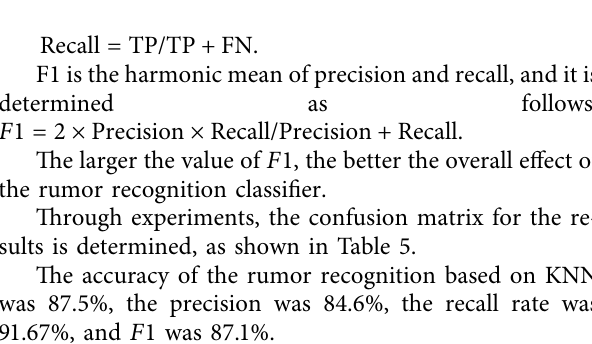
Figure 7: Nonrumor C-C algorithm